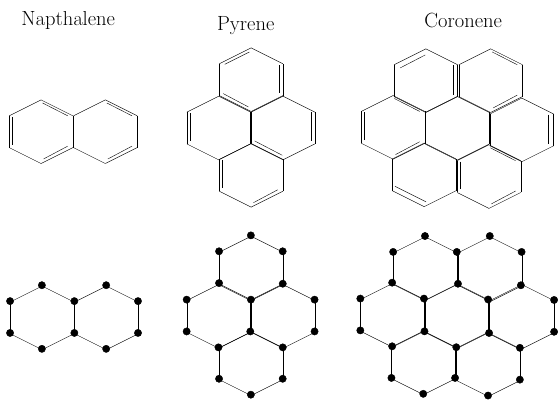
Figure 1. The molecular graphs of some polycyclic aromatic